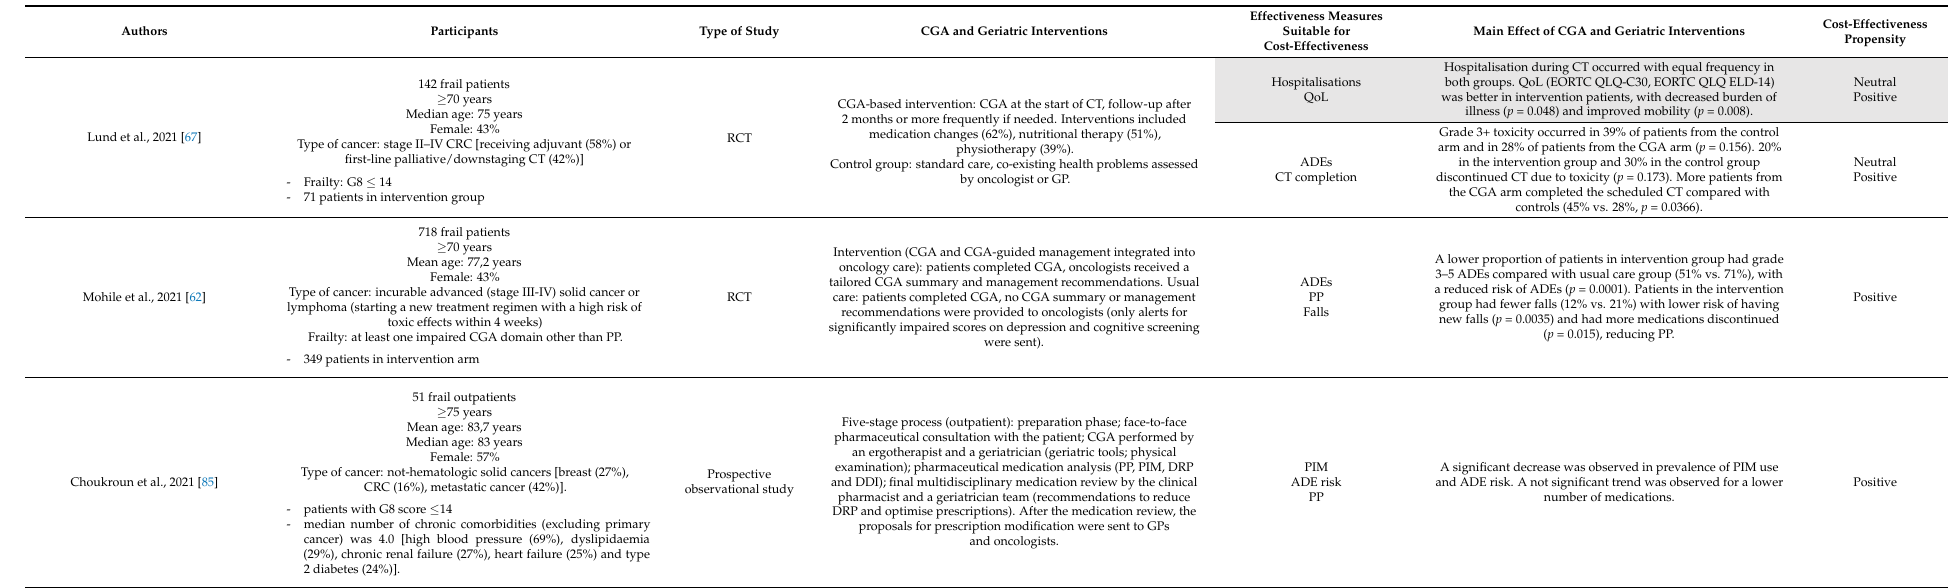
Table 3. Studies conducted in medical settings, main features and